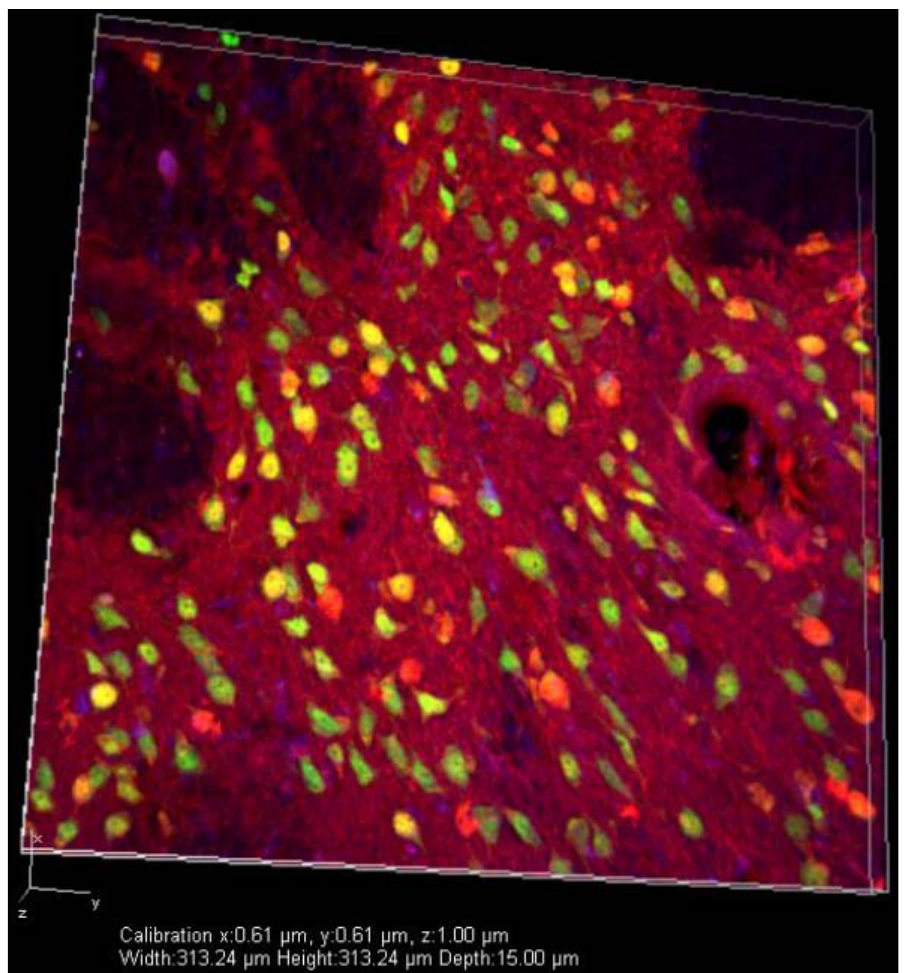
Figure 4. Confocal image of iPSCs transplanted in the 3-NP rat brain: Immunohistochemical analysis of transplanted iPSCs (blue), mature neurons (NeuN; green), and medium spiny neurons (DARPP32; red). Transplanted rats displayed surviving iPSCs (blue) around the injection site at the conclusion of the